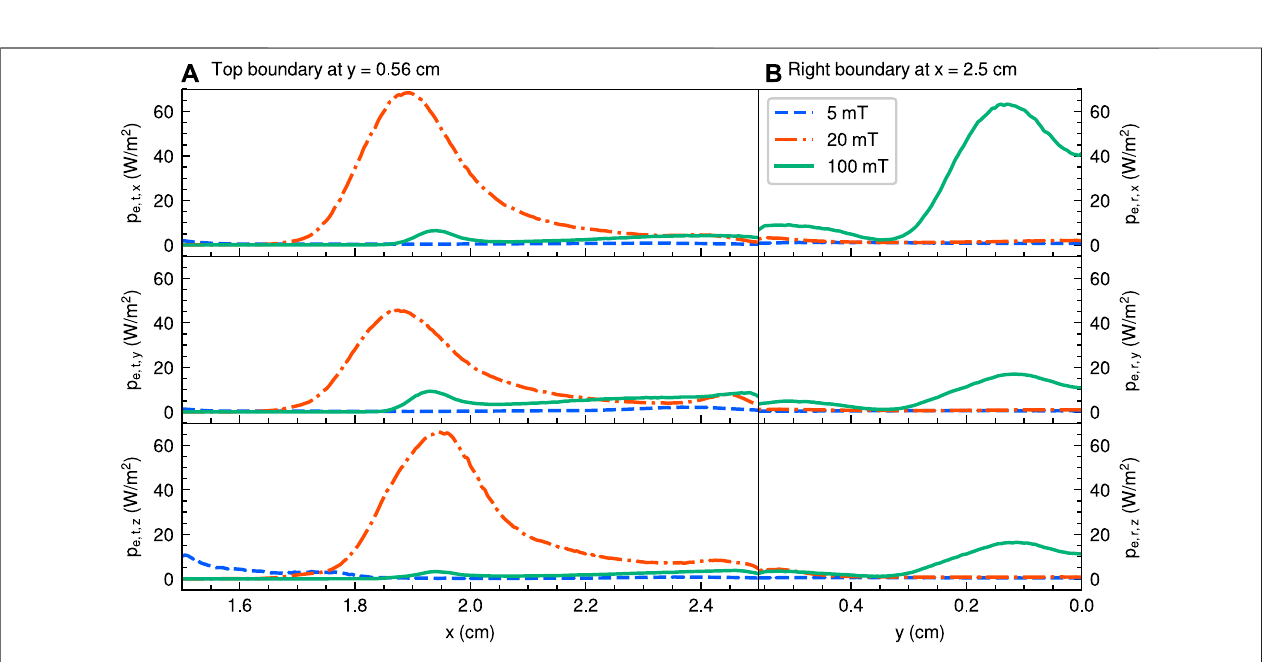
Frontiers in Physics |